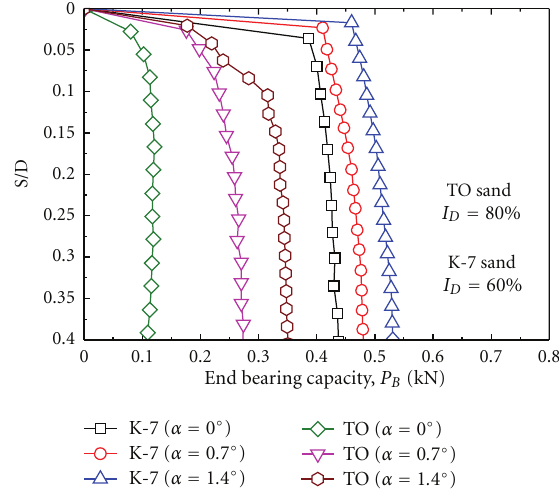
Figure 2: End-bearing resistance of K-7 and TO